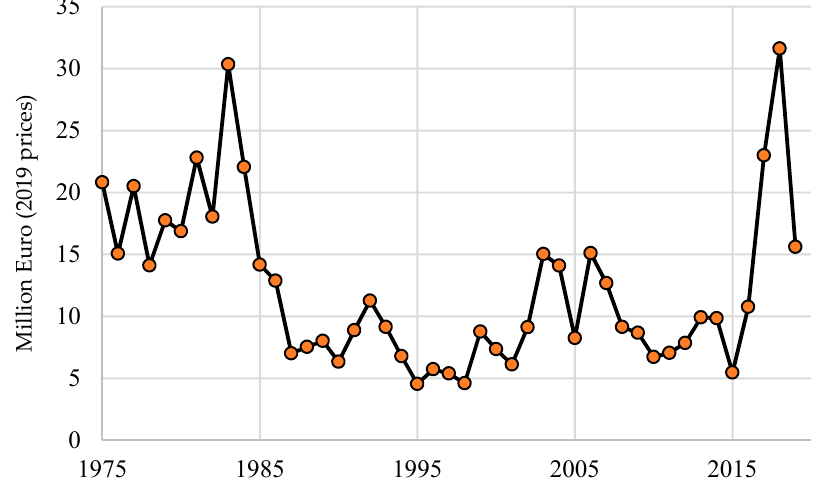
Figure 2. Government R&D Expenditures Relating to Industrial Energy Use in Sweden, 1975–2019 Source: International Energy Agency [65]. The data include national government funding to support the installation of pilot and demonstration plants.